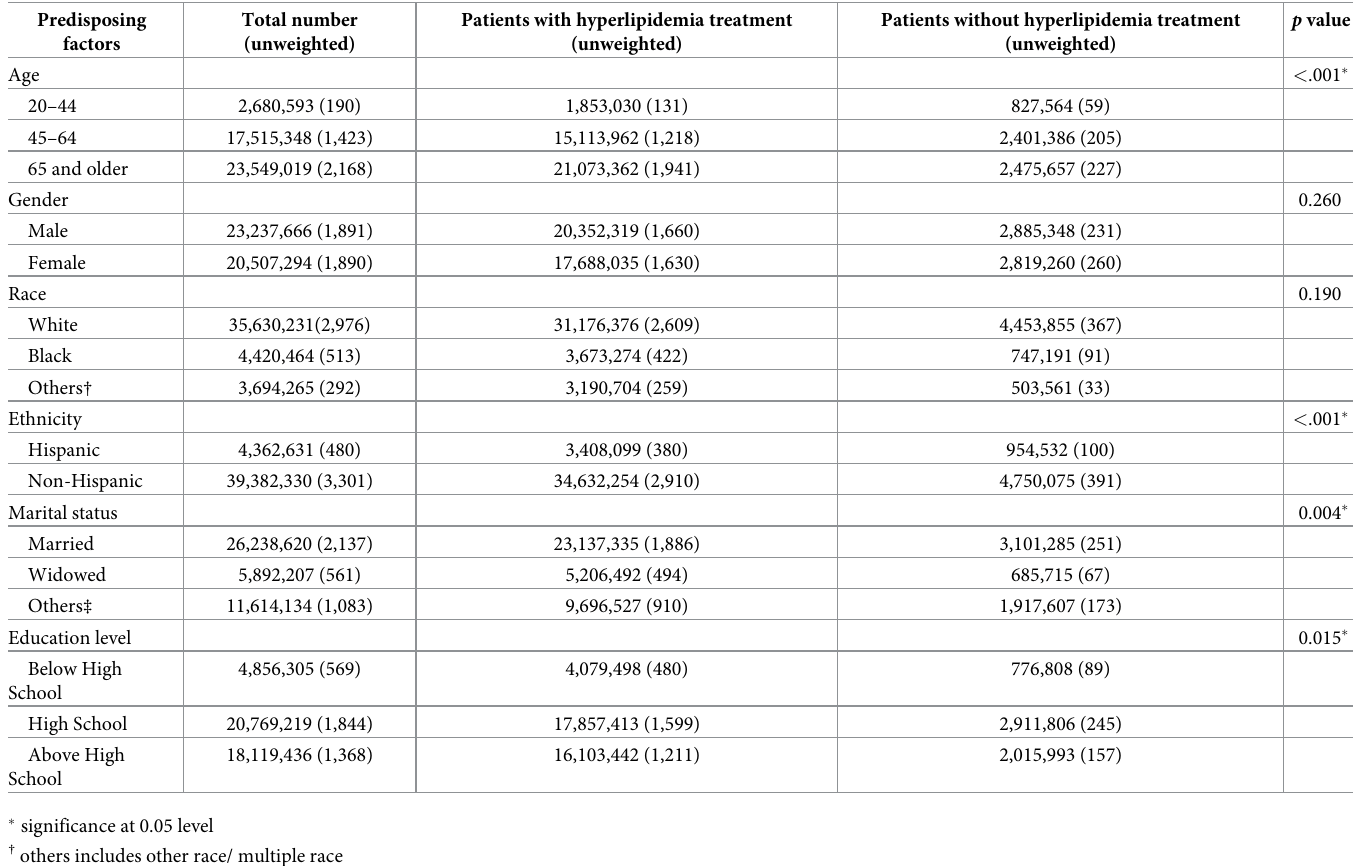
Table 1. Population characteristics; predisposing